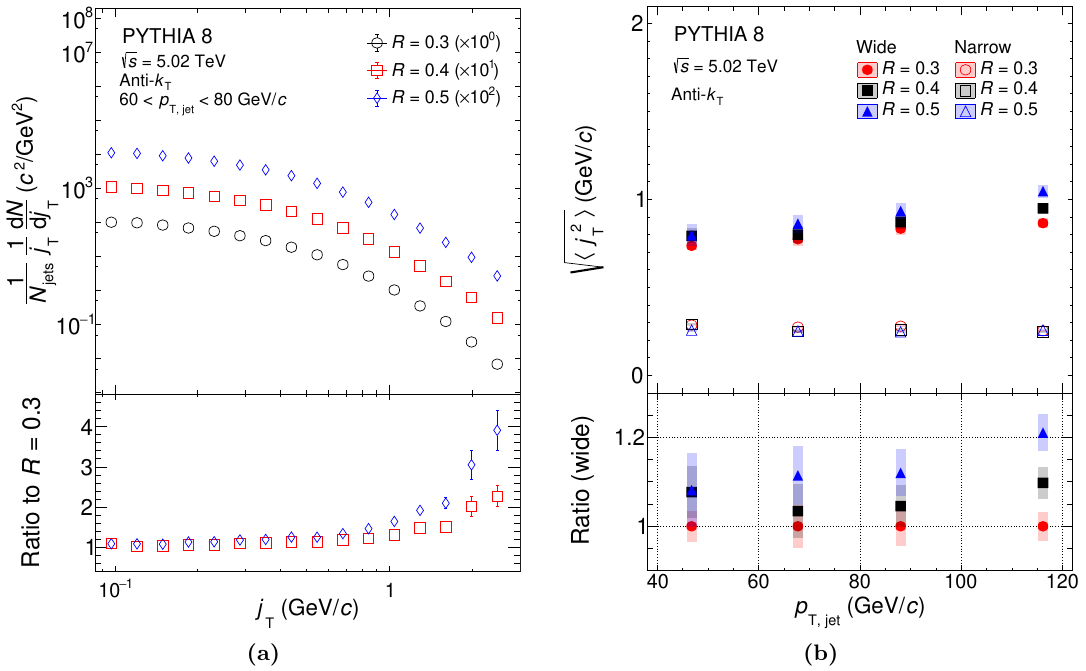
Figure 7. The effect of changing the R parameter in jet finding on j T distributions obtained with PYTHIA 8 simulations. Comparison of (a) j T signal distributions for different R parameters and their ratios to that of R = 0 . 3 and (b) RMS values of the wide and narrow components and their ratios to that of R = 0 . 3 for the wide component